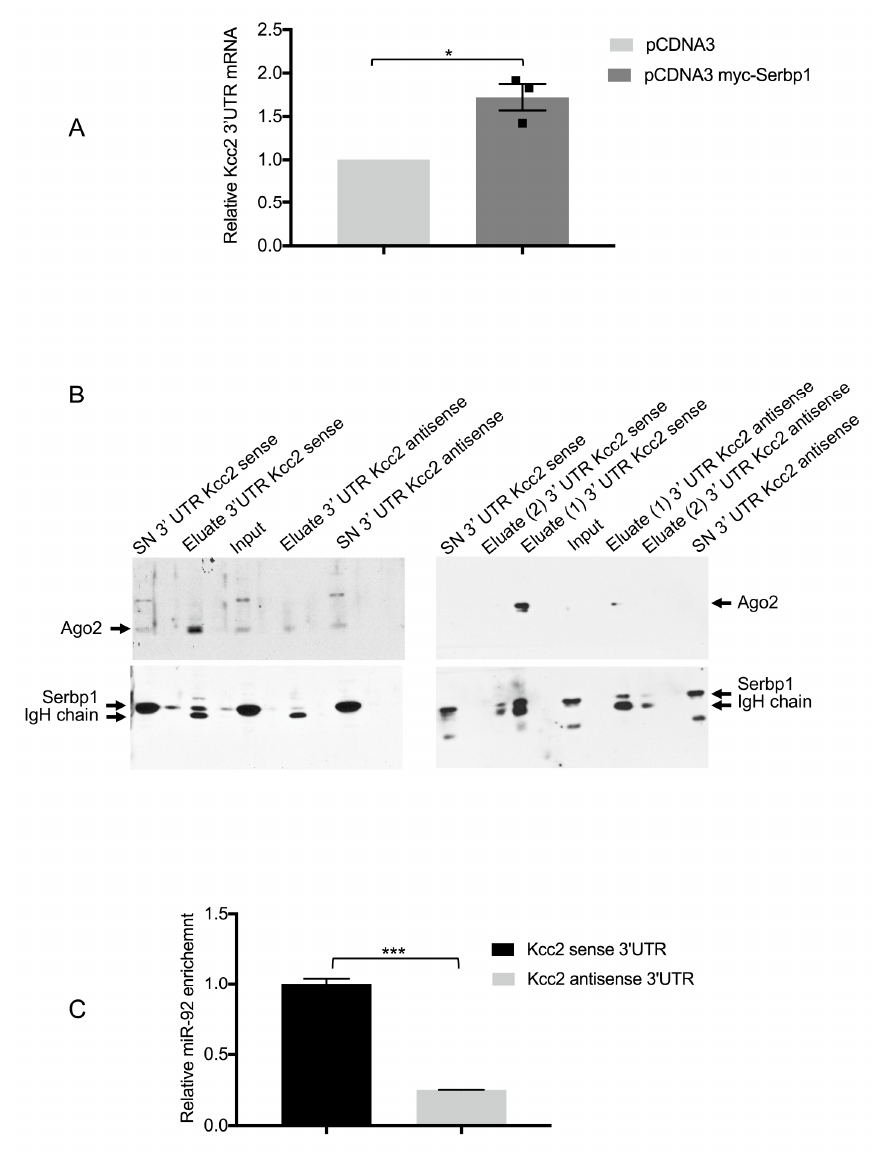
Figure 4. SERBP1 interacts with KCC2 3 ′ UTR. ( A ) SH-SY5Y cells were co-transfected with pCDNA3- myc or pCDNA3 myc-SERBP1 together with KCC2 3 ′ UTR. Immunoprecipitates were analyzed by qRT-PCR to determine the levels of KCC2 mRNA in the two different conditions. Data represent the mean of three independent experiments ± S.E.; * p < 0.05. Individual data points for pcDNA3 myc-Serbp1 (squares) transfected cells are shown. ( B ) Western blotting showing Ago2 and SERBP1 protein levels in the input, eluates and supernatants from cytoplasmic lysates of SH-SY5Y cells (left panels) or hippocampal neurons (right panels) incubated with KCC2 sense or antisense 3 ′ UTR transcripts. Eluate (1) and eluate (2) indicate the first and second elution. ( C ) Levels of miR-92 bound to KCC2 sense or antisense 3 ′ UTR transcripts were analyzed by qRT-PCR. Δ Ct values were normalized to the snU6 level *** p < 0.001.